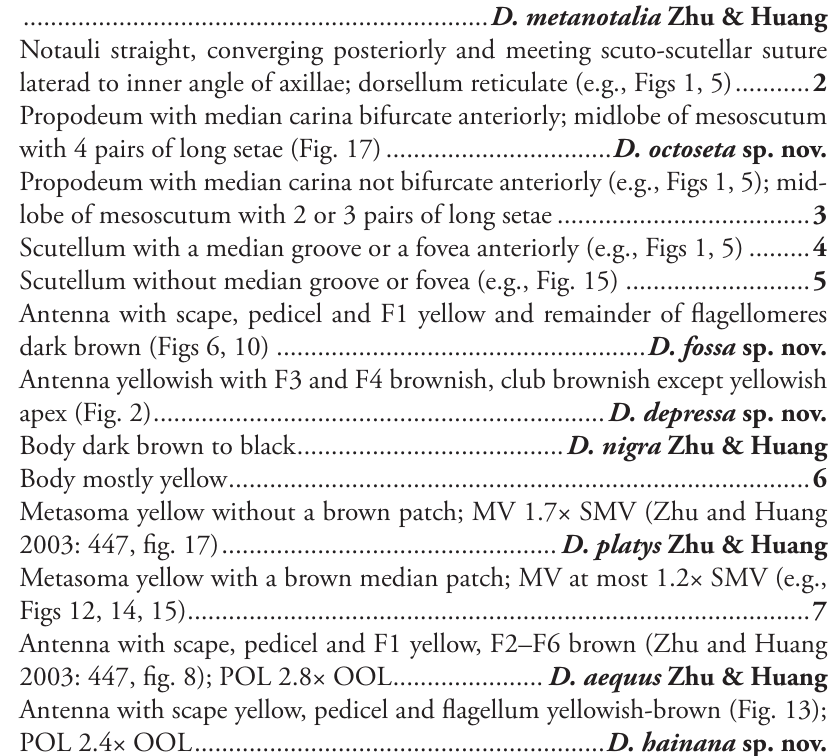
ning from posterior part of each plica to outer margins of propodeum. Gaster subsessile. Key to Chinese species of Diglyphomorphomyia based on females 1 Notauli strongly divergent posteriorly meeting inner angle of axillae; dorsel- lum smooth (Fig. 11 page 447 of Zhu and Huang 2003)..............................